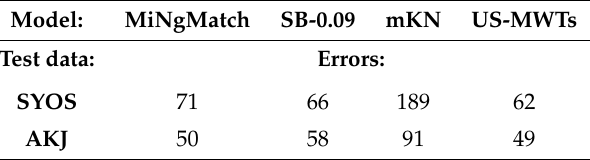
Table 13. Statistics of word segmentation errors.